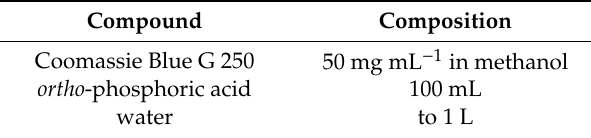
Table 1. Composition of the Bradford reagent.